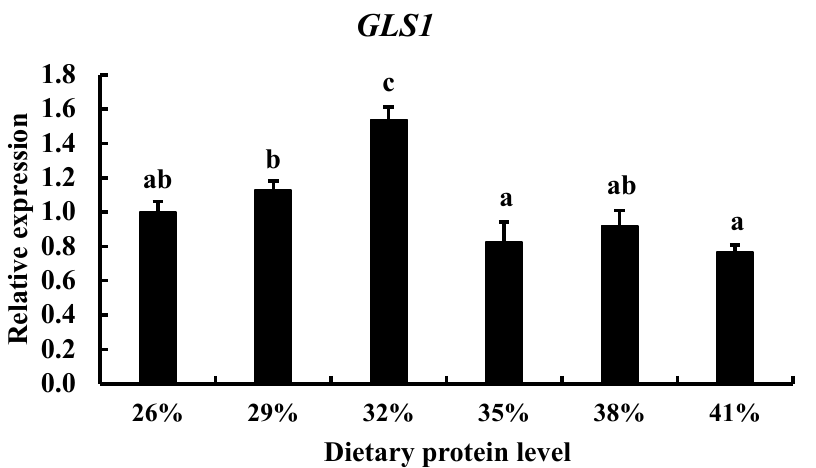
than that in the control group. Figure 4. Circadian rhythm analysis of gls1 mRNA expression in TCC muscle. Different letters represent significant difference ( p < 0.05, n = 9 for each bar).